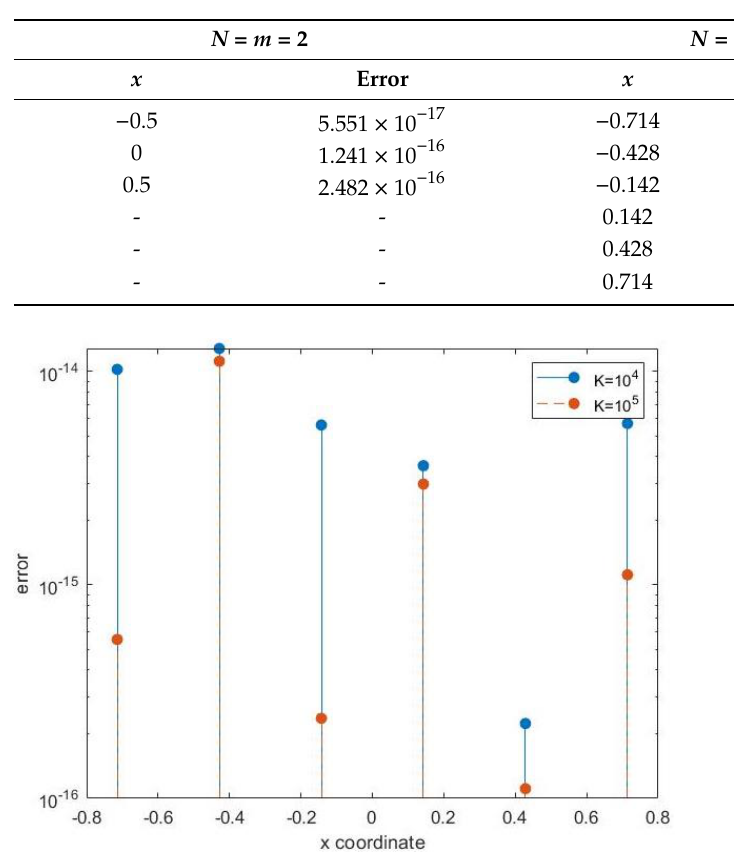
Figure 2. The absolute error for N = 5, m = 2.